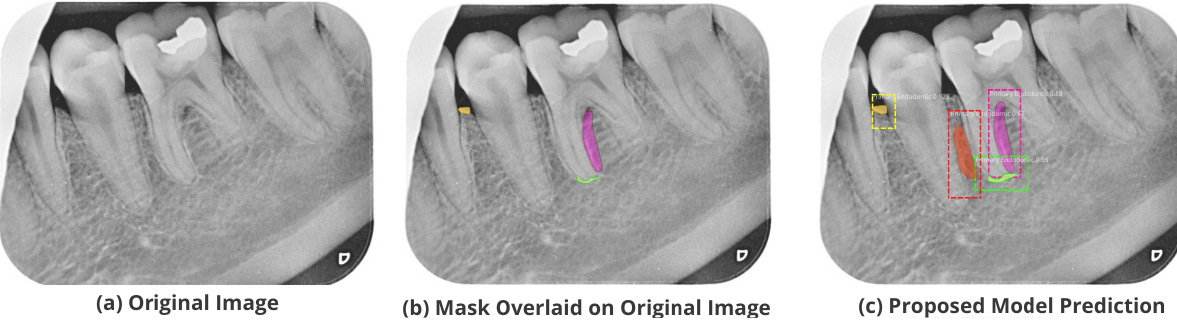
Figure 11. Test performance for the localization of a ’Primary Endodontic’